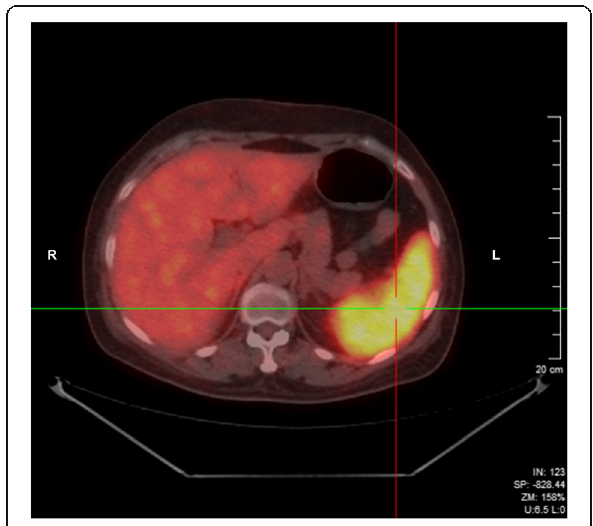
Fig. 1 PET-CT of spleen. PET-CT scan revealed spleen abnormality with SUV max 10.2